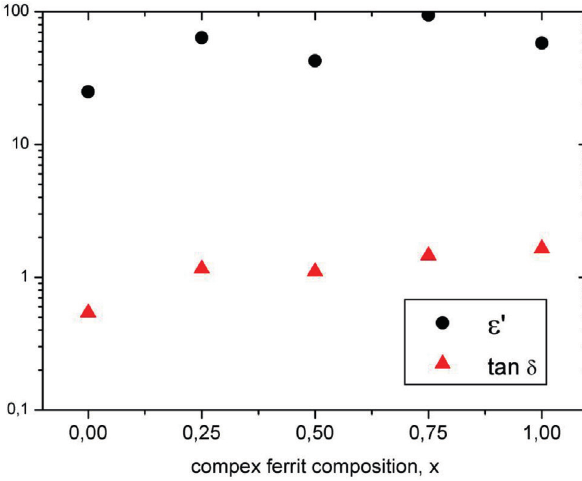
Fig. 3: The variation of the real part of the dielectric constant and loss factor with respect to composition at 293 K and 1